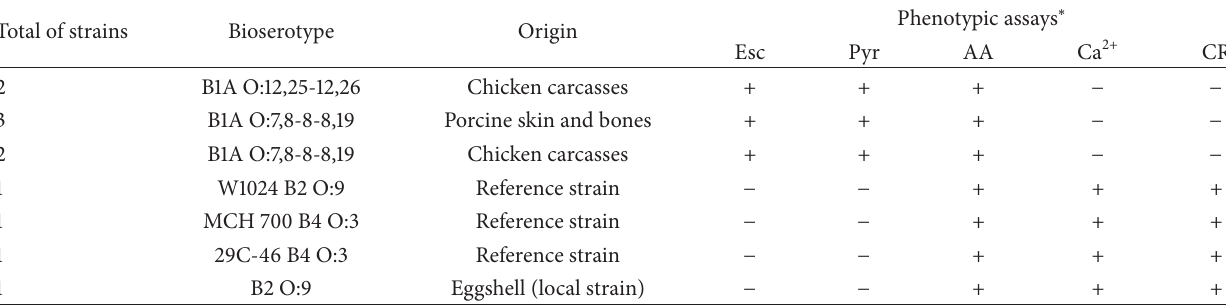
Table 3: Phenotypic virulence assays corresponding to Y. enterocolitica strains. Total of